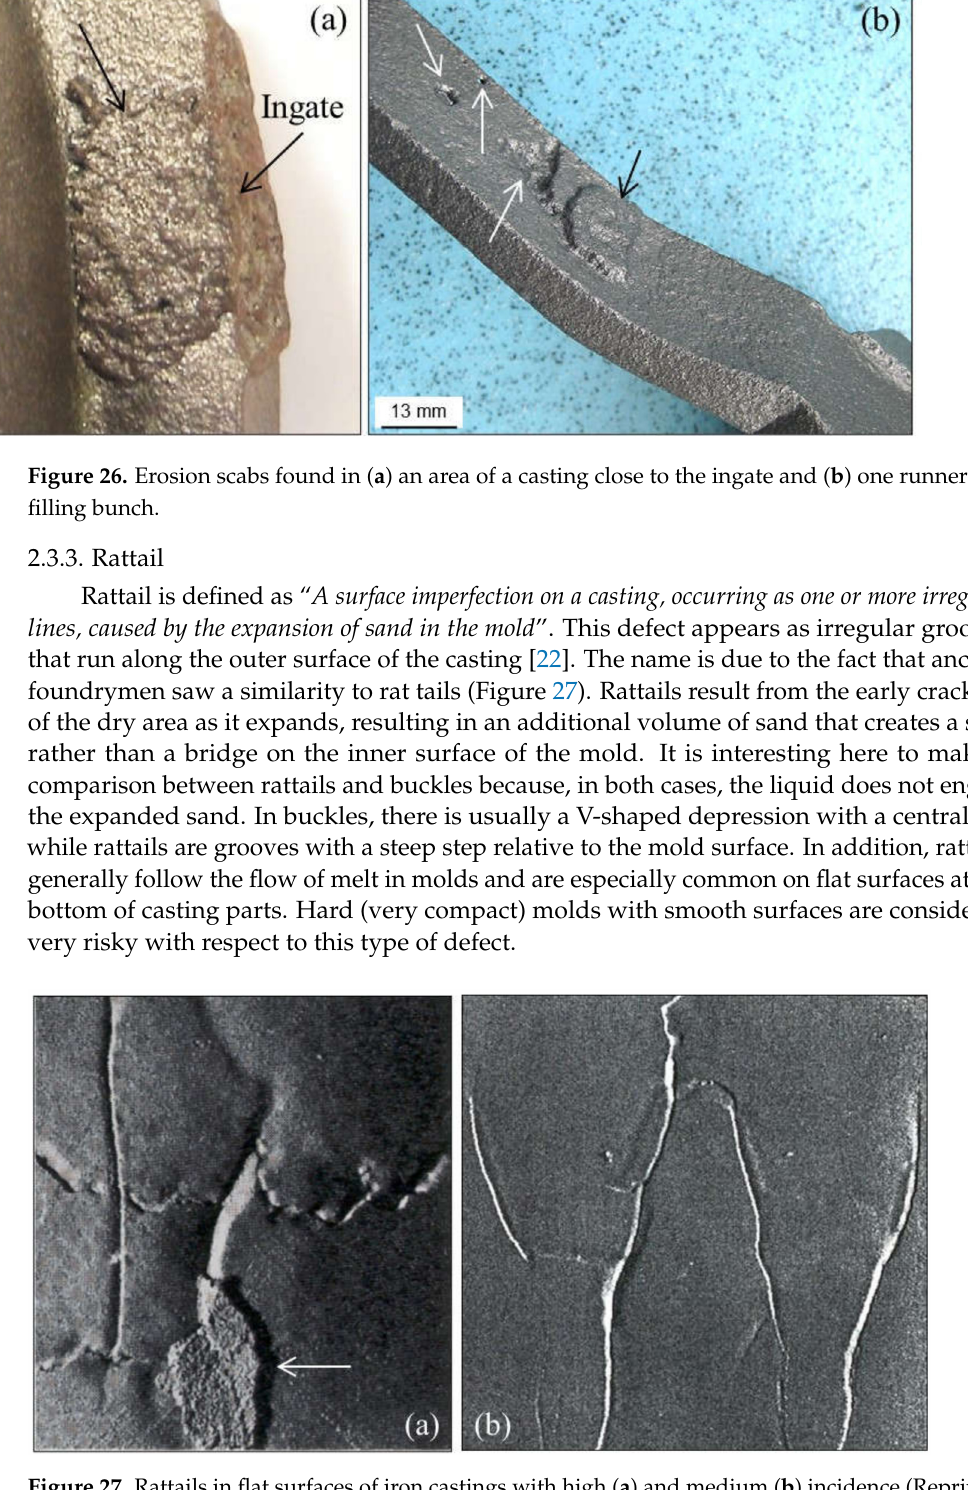
Figure 27. Rattails in flat surfaces of iron castings with high ( a ) and medium ( b ) incidence (Reprinted with permission from ref. [17]. Copyright 1999 American Foundry Society, page 186). In ( a ) a common scab (highlighted with a white arrow) is formed together with